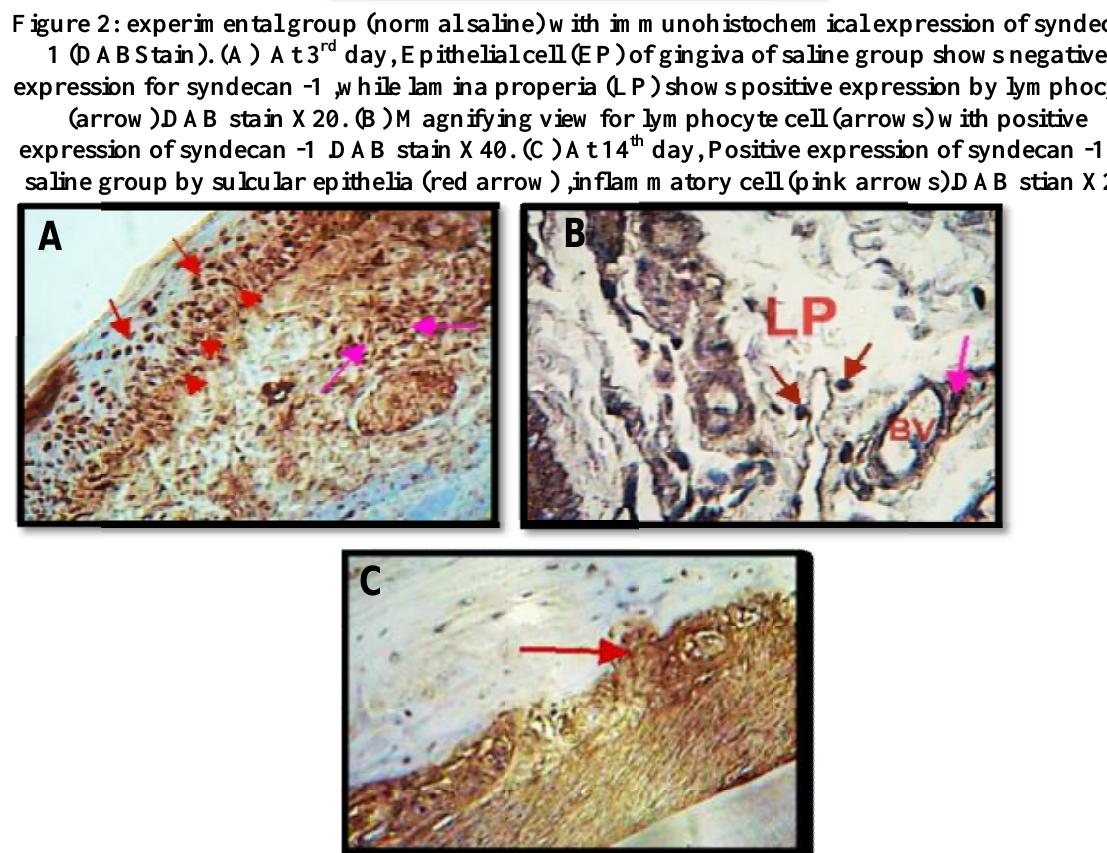
Figure Figure 3: experimental group experimental group experimental group (Aloe vera) with (Aloe vera) with immunohistochemical expression of syndecan 1 immunohistochemical expression of syndecan 1 immunohistochemical expression of syndecan 1 immunohistochemical expression of syndecan 1 immunohistochemical expression of syndecan 1 (DAB (DAB Stain). (A) At 3 A) At 3 rd day, Positive expression of syndecan day, Positive expression of syndecan day, Positive expression of syndecan day, Positive expression of syndecan -1 by keratinocyte cells include 1 by keratinocyte cells include 1 by keratinocyte cells include 1 by keratinocyte cells include basal cell (red arrow heads),prickle cell (redarrows),inflammatory cell (pink arrows).DAB stain basal cell (red arrow heads),prickle cell (redarrows),inflammatory cell (pink arrows).DAB stain basal cell (red arrow heads),prickle cell (redarrows),inflammatory cell (pink arrows).DAB stain basal cell (red arrow heads),prickle cell (redarrows),inflammatory cell (pink arrows).DAB stain basal cell (red arrow heads),prickle cell (redarrows),inflammatory cell (pink arrows).DAB stain basal cell (red arrow heads),prickle cell (redarrows),inflammatory cell (pink arrows).DAB stain basal cell (red arrow heads),prickle cell (redarrows),inflammatory cell (pink arrows).DAB stain basal cell (red arrow heads),prickle cell (redarrows),inflammatory cell (pink arrows).DAB stain basal cell (red arrow heads),prickle cell (redarrows),inflammatory cell (pink arrows).DAB stain X 10. (B) X 10. (B) At 7 th day, Lamina propria (LP) shows positive expression of syndecan day, Lamina propria (LP) shows positive expression of syndecan day, Lamina propria (LP) shows positive expression of syndecan day, Lamina propria (LP) shows positive expression of syndecan day, Lamina propria (LP) shows positive expression of syndecan day, Lamina propria (LP) shows positive expression of syndecan day, Lamina propria (LP) shows positive expression of syndecan -1 by plasma 1 by Oral Diagnosis Oral Diagnosis 84